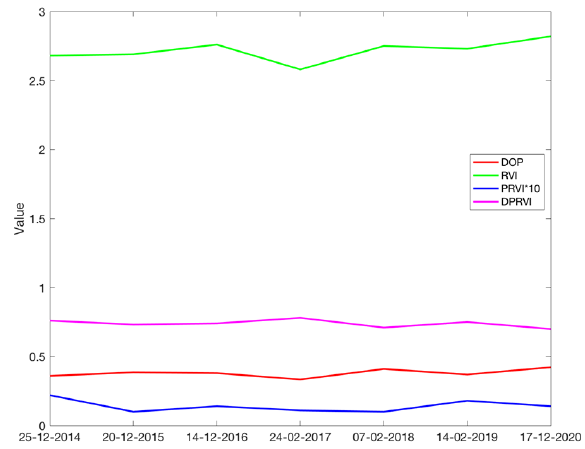
Figure 1: Sentinel 1 SLC spectral response of RVI, DpRVI, PRVI and DOP of the degraded Riparian Reserve 2014-2020 of Lake Nakuru, Kenya.